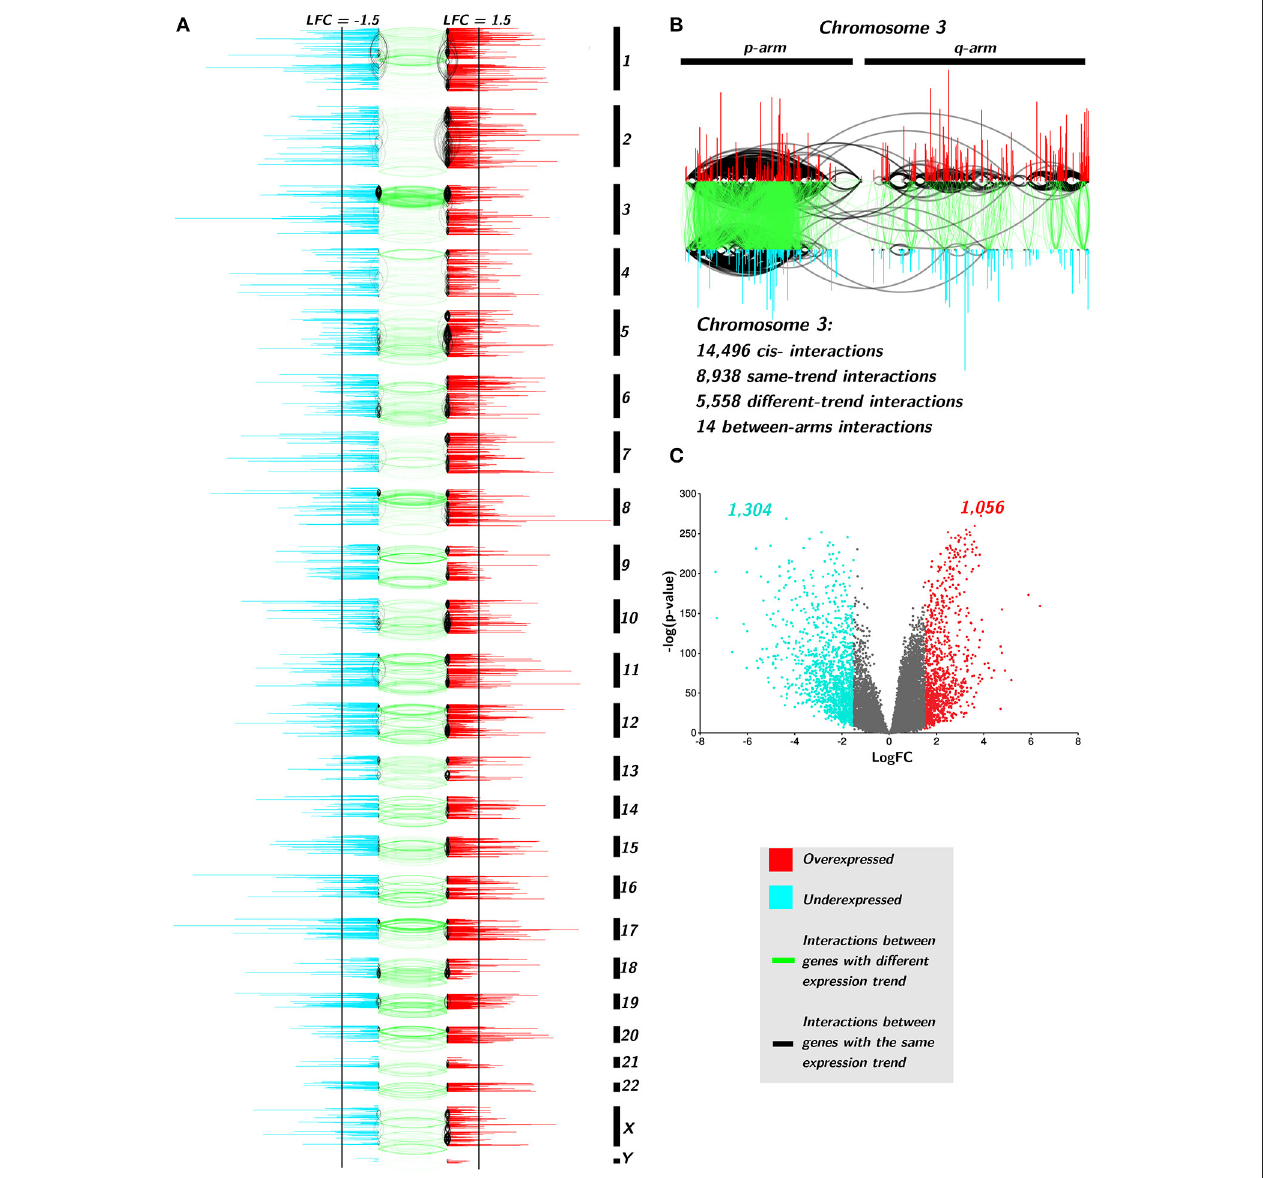
FIGURE 6 | Differential expression trend influences the interactions of TAD network. (A) Genes are placed according to its starting base per chromosome. Color of genes takes account for the differential expression trend: red for positive differential expression and turquoise for negative ones. Black vertical lines indicate the threshold point for differential expression ( ± 1.5). Black edges join genes with the same differential expression trend, meanwhile green links represent interactions between different trend genes. (B) Zoom-in to Chr3. (C) volcano plot for TAD genes with the aforementioned